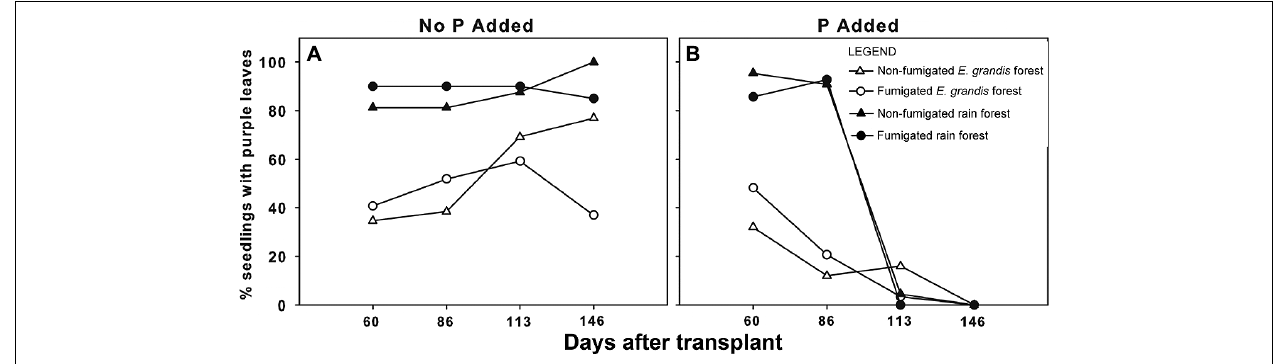
DAT were: non-fumigated E. grandis ( n = 26 no P added, 25 P added), Fumigated E. grandis ( n = 27 no P added, 29 P added), Non-fumigated rain forest ( n = 16 no P added, 22 P added) and Fumigated rain forest ( n = 20 no P added, 28 P added). Thirteen seedlings which were diseased at 146 DAT were